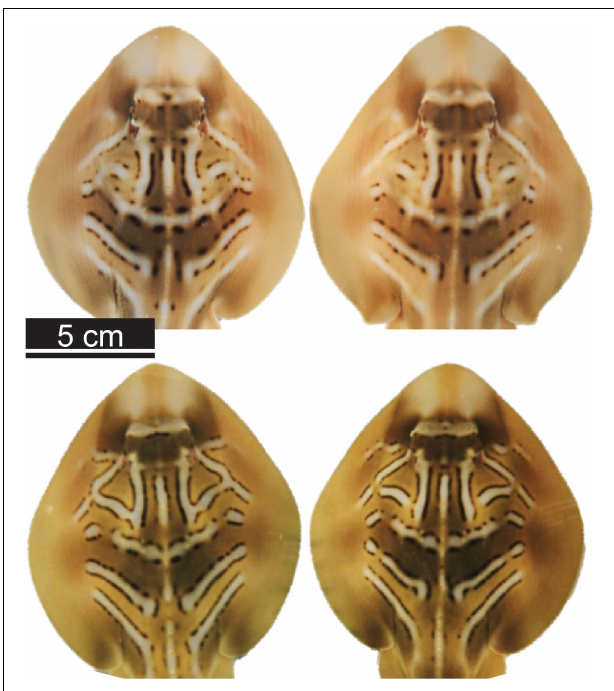
FIGURE 1 | Dorsal photos of southern fiddler ray ( Trygonorrhina dumerilii ) neonates. Photos show the similarity in coloration and pattern between pairs of siblings (pair A, top two photos; and pair B, bottom two